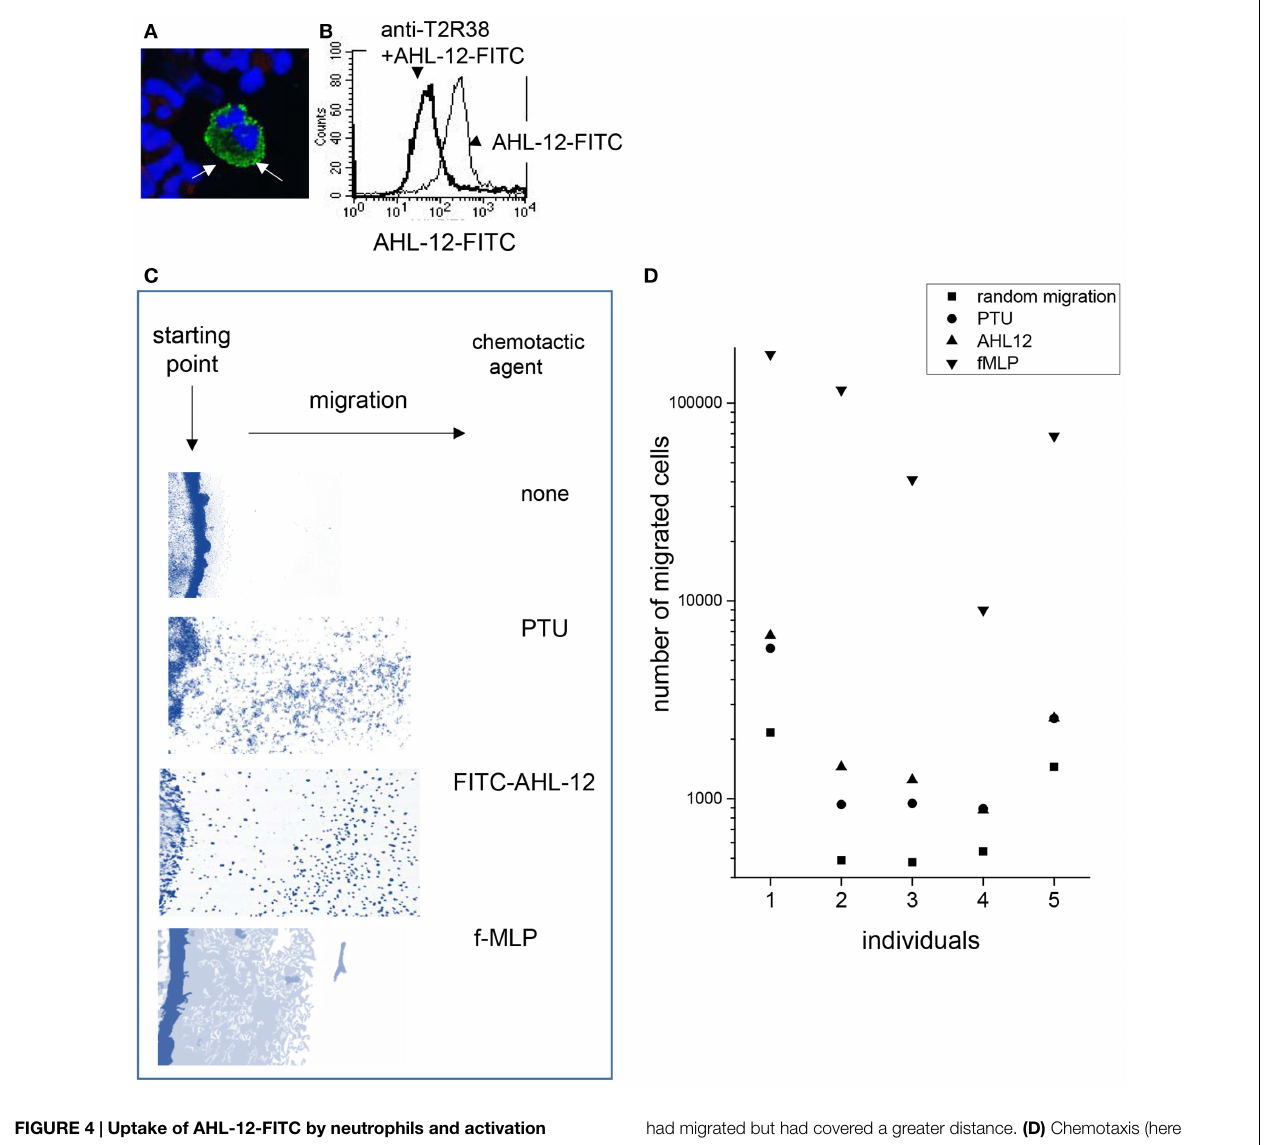
FIGURE 4 | Uptake of AHL-12-FITC by neutrophils and activation of cells: laser scan microscopy (A) and cytofluorometry (B) revealed binding of AHL-12-FITC to neutrophils (thin line) . Binding could be inhibited by anti-T2R38 (sc-34294) (thick line) (C) AHL-12-FITC induced migration of neutrophils shown by “under-agarose” migration (cells are stained in blue), as did PTU. In comparison to f-MLP, fewer cells